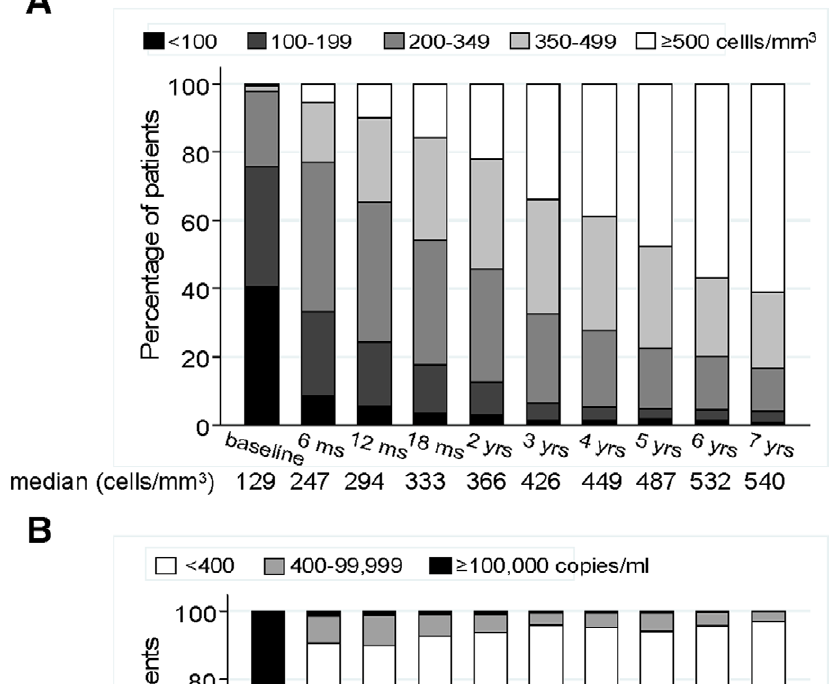
Figure 1. Distribution of CD4 count (A), viral load (B) and haemoglobin (C) over time from initiation of cART. The closest measurement to each nominal time points within a 6 3 months window was selected for each patient.